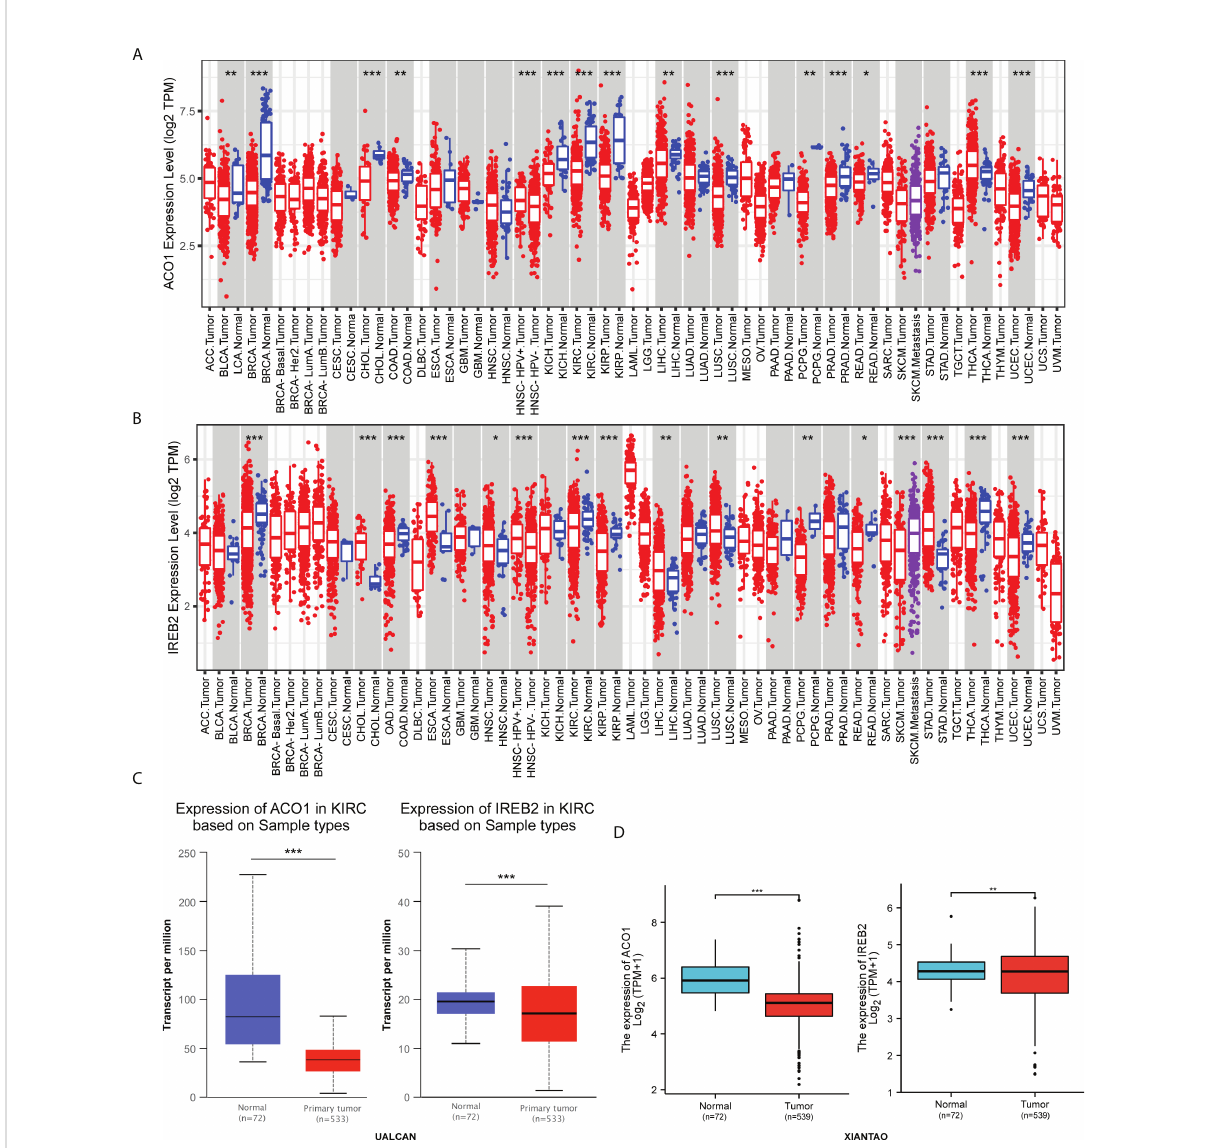
FIGURE 1 Expression of ACO1 and IREB2 in kidney renal clear cell carcinoma (KIRC). (A, B) ACO1 (A) and IREB2 (B) expression in different types of cancer was investigated with the Tumor Immune Estimation Resource (TIMER) database. (C) ACO1 and IREB2 expression in KIRC was examined by using the UALCAN database. (D) Analysis of ACO1 and IREB2 expression in KIRC and adjacent normal tissues in the TCGA database. *P < 0.05; **P < 0.01; ***P <